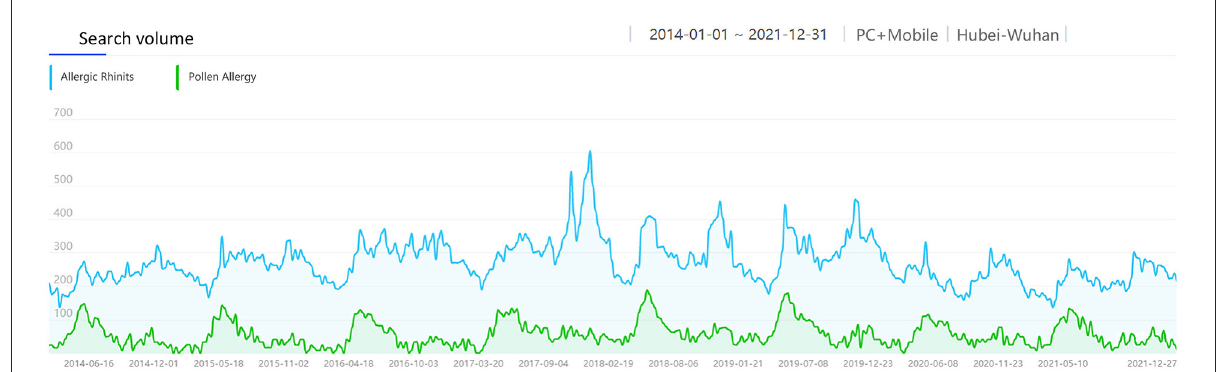
FIGURE6 The search volume of “Pollen Allergy” in Wuhan from 2014 to 2021.